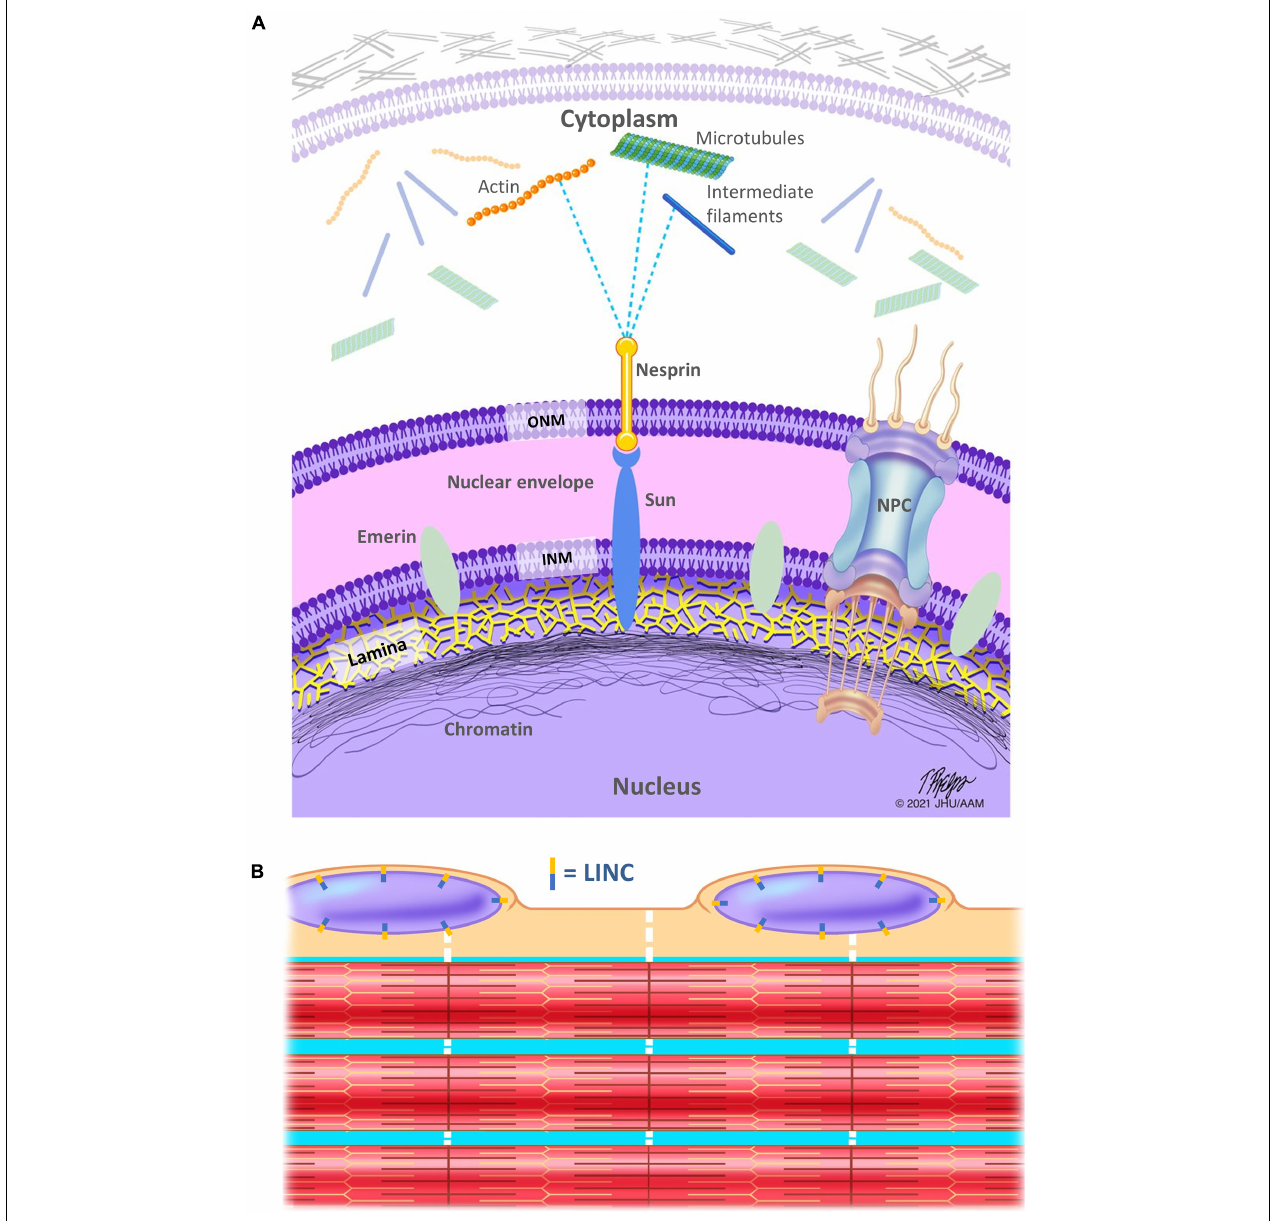
FIGURE 1 | Schematic representation of the linker of nucleoskeleton and cytoskeleton (LINC) complex. (A) The nuclear lamina is a meshwork of intermediate filaments (lamins), localized on the inner aspect of the inner nuclear membrane and helps to stabilize the nuclear envelope. The lamina is in direct contact with the chromatin, which is denser at the nuclear periphery. SUN proteins connect the inside of the nucleus to nesprins, which serve as a link between the nucleus and the myofiber cytoskeleton (including but not limited to microtubules, the actin, and desmin IFs), directly or indirectly via plectin, a cytoskeletal link in the cytoplasm. INM, inner nuclear membrane; ONM, outer nuclear membrane; NPC, nuclear pore complex. (B) Schematic showing only a few of the hundreds of myofibrils within a single muscle fiber (aka myofiber). Nuclei are located along the periphery of myofibers. Note that the LINC complex is located circumferentially around the nuclear membrane (aka nuclear envelope). Dotted white lines indicate the cytoskeletal IFs that connect the myofibrils to each other, to the sarcolemma, and to the